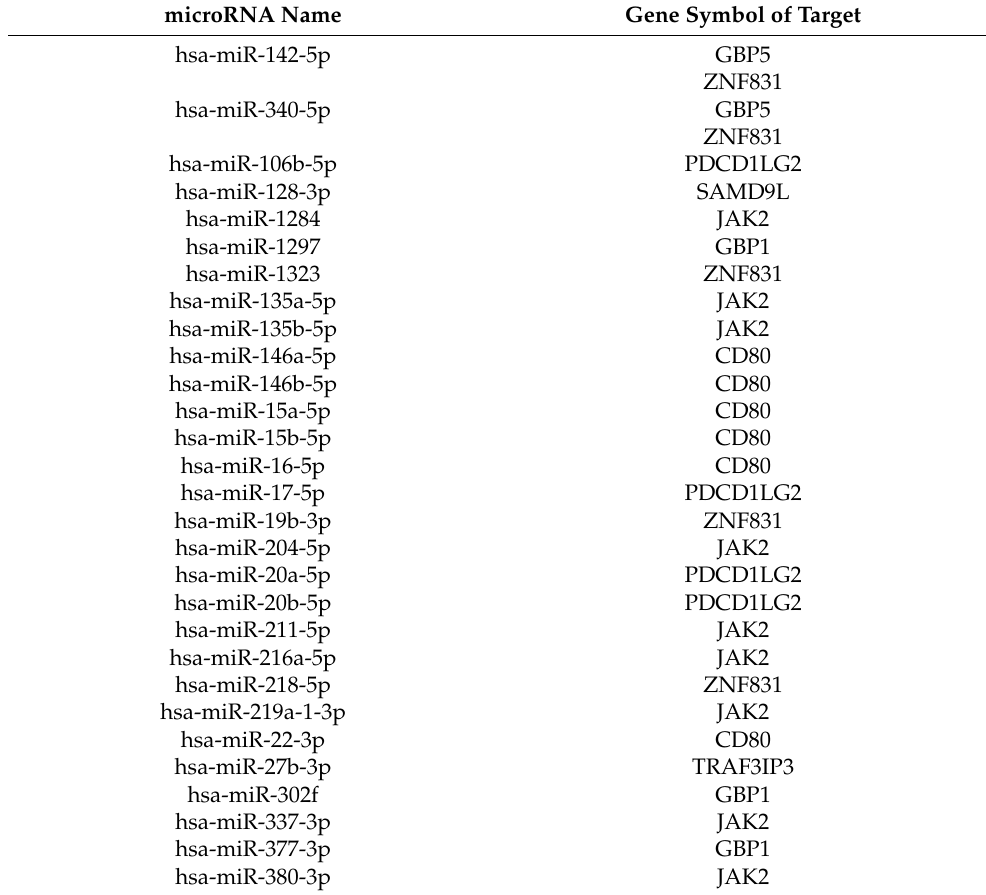
Table 4. MicroRNAs identified in both miRDB and miRabel that putatively target CD274, PDCD1, or their correlated genes. Forty-seven of 49 microRNAs targeted a gene positively correlated with CD274/PDCD1; 2 of 49, indicated by an asterisk (*), targeted a gene negatively correlated with